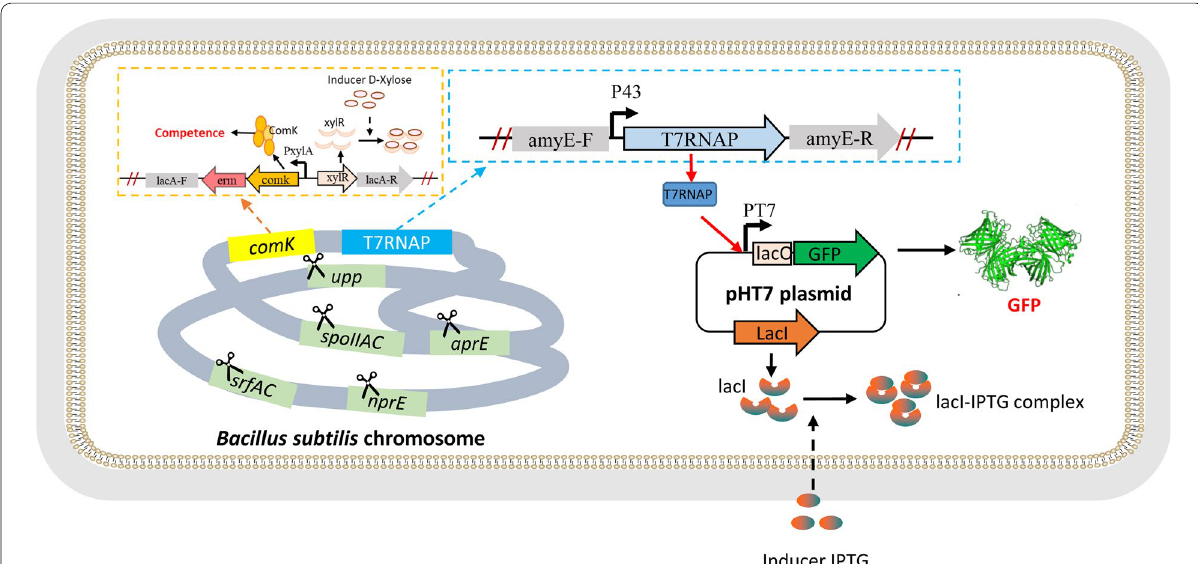
Fig. 1 Schematic representation of the industrial host SCK22 harboring plasmid pHT7. After xylose induction, under the control of xylose‑inducible promoter, comK gene was expressed and then super receptive cells were formed. Endogenous protein genes and fermentation‑related genes were knocked out on the genome to make it suitable for high‑density fermentation. The P 43 promoter enabled the constitutive expression of T7 RNA polymerase, and the expression plasmid encoded the target gene, where the T7 promoter was under the control of the lac